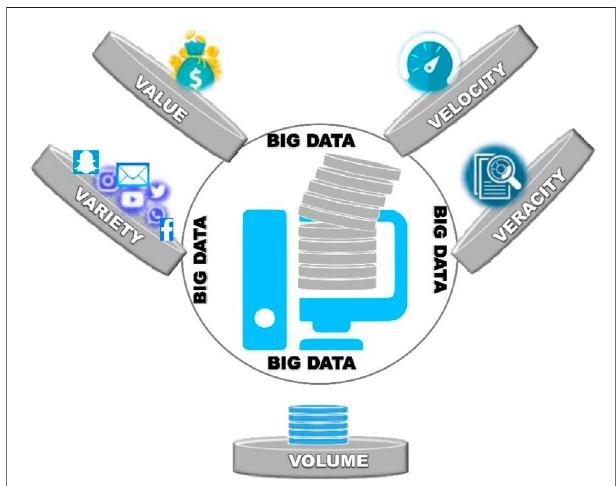
FIGURE 1 | 5 Vs of big data characterization for depression.